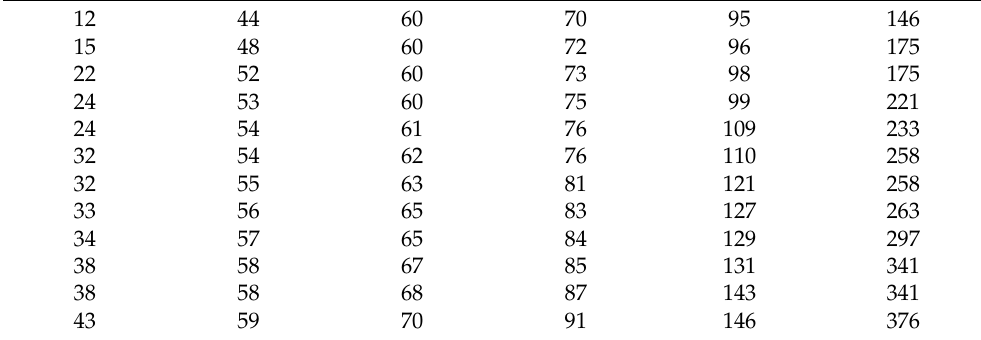
Table 2. Lifetimes of Cavia Porcellus injected with various doses of Mycobacterium Tuberculosis.